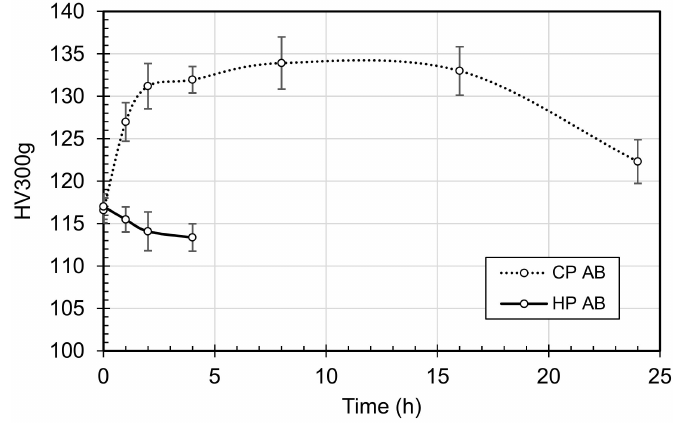
Figure 7. Aging curves at 160 ◦ C of as-built SLM-processed AlSi10Mg